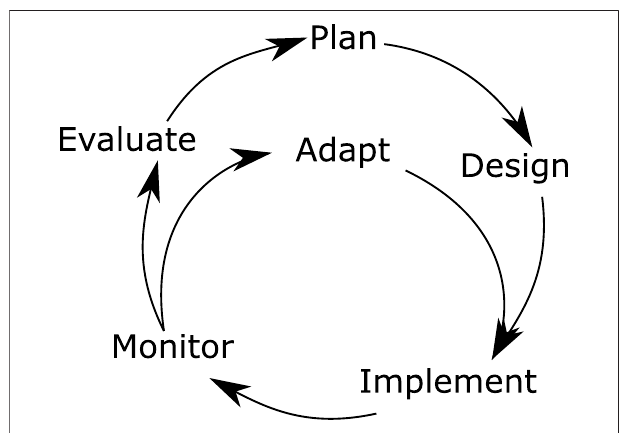
FIGURE 7 | Adaptive management cycle, adapted from (CEDA, 2015a, b) copyright